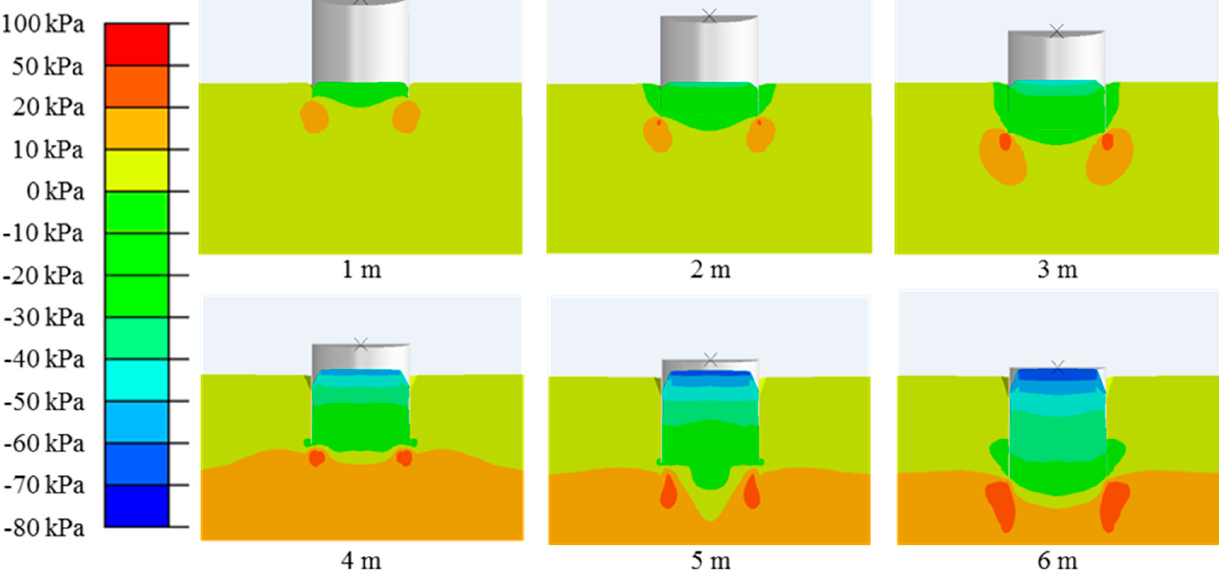
Figure 9. Excess pore pressure at different suction penetration depths.